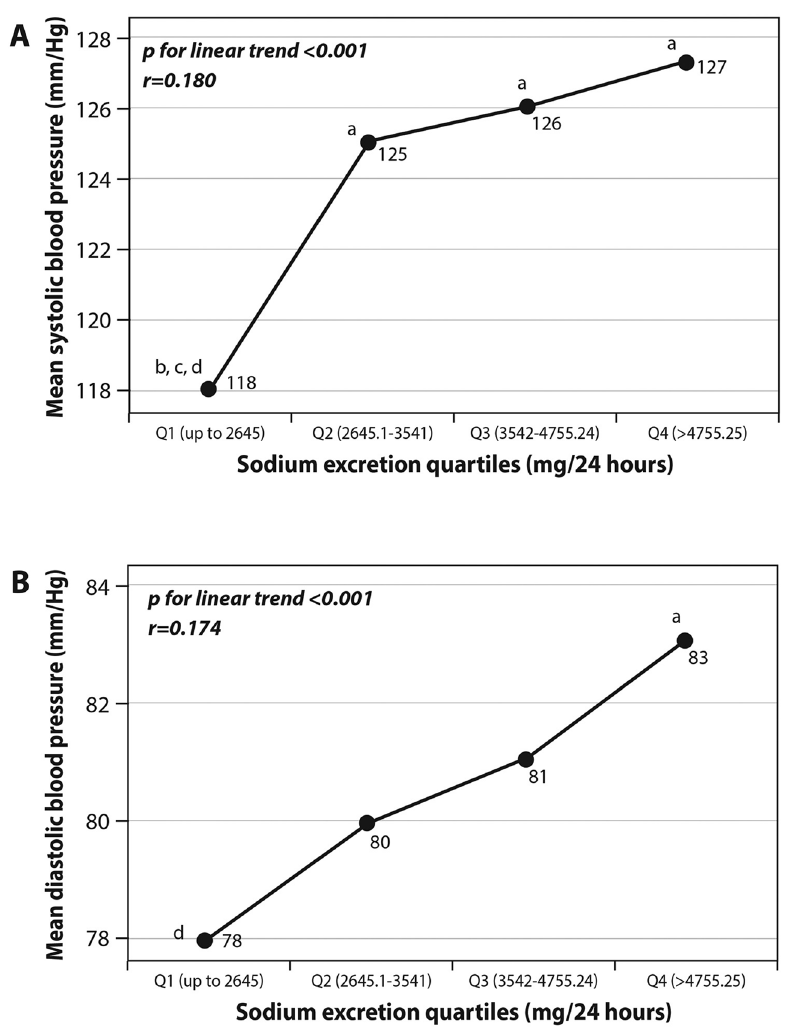
of variance [ANOVA]) are represented by the following letters: a = significantly different than Q1 (p < 0.05); b = significantly different than Q2 (p < 0.05); c = significantly different than Q3 (p < 0.05); d = significantly different than Q4 (p <